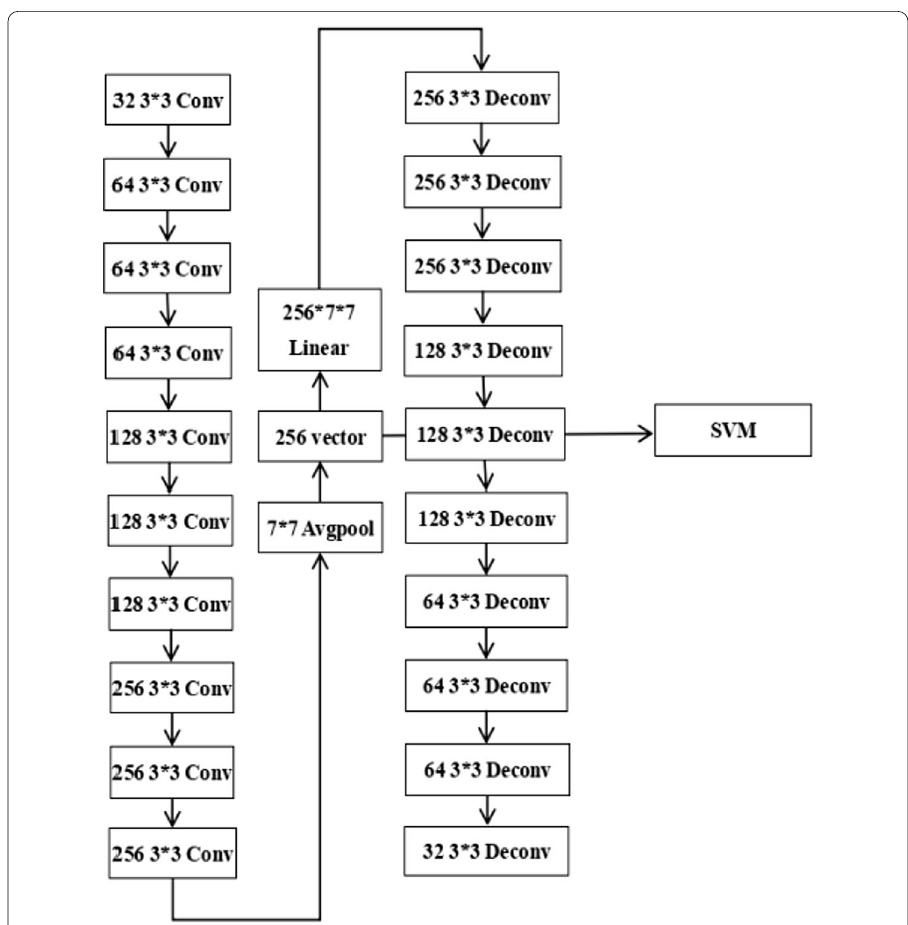
Fig. 6 The structure of the expression recognition model